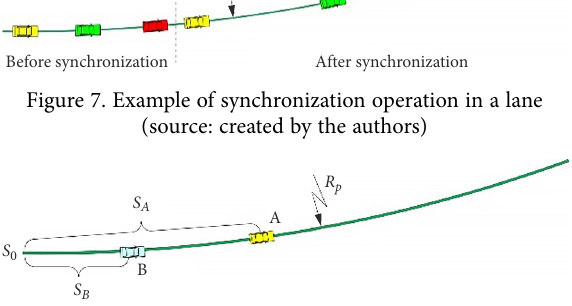
Figure 8. Path position (source: created by the